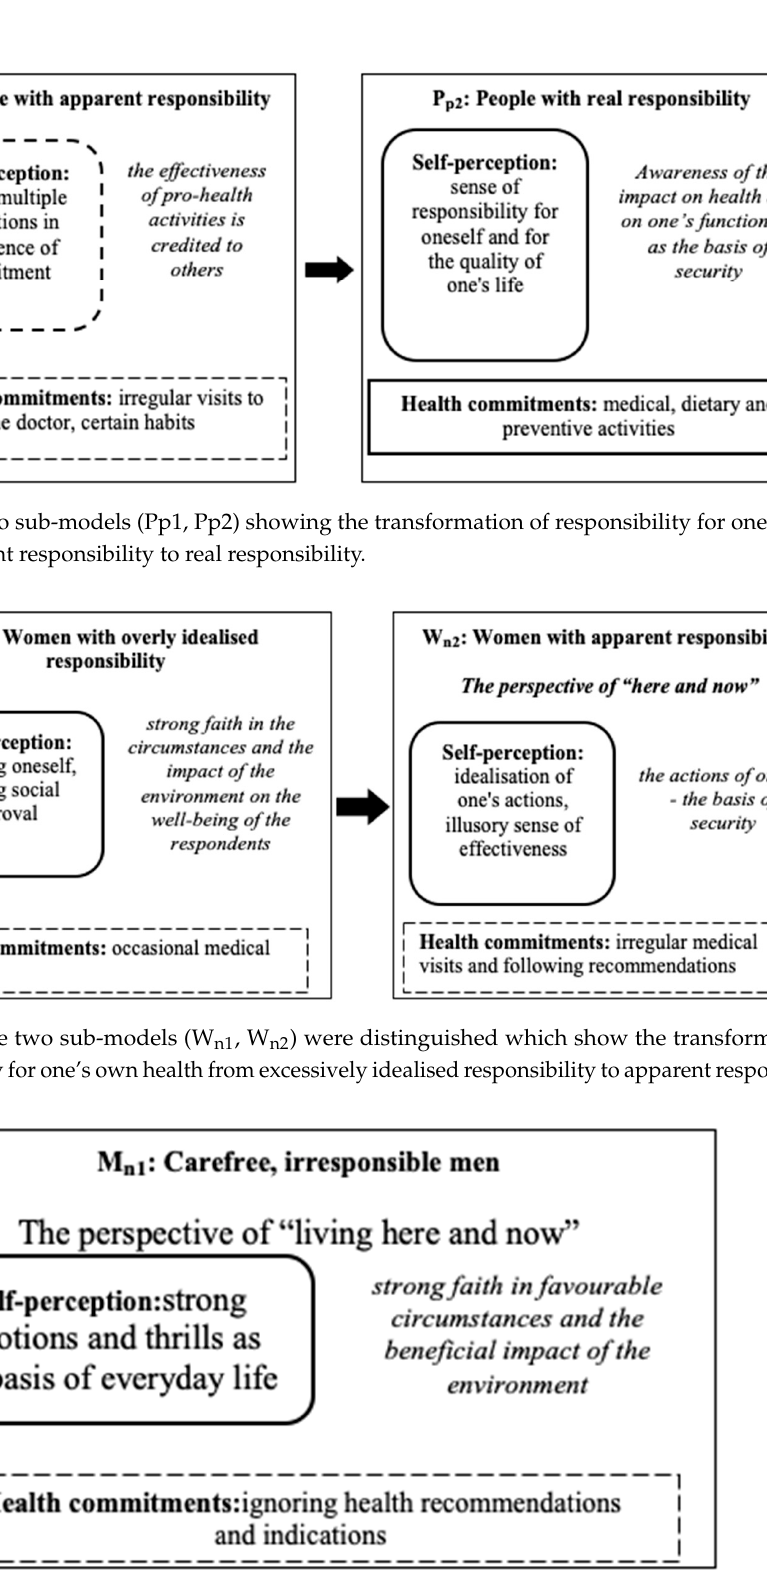
9 of 15 Figure 3. The sub-model of responsibility for their own health (Mo 1 ) among men. The sub-model consisted of three men who refrained from driving fast. The respond- ents showed consistency of declarations regarding the criteria of health with actions un-